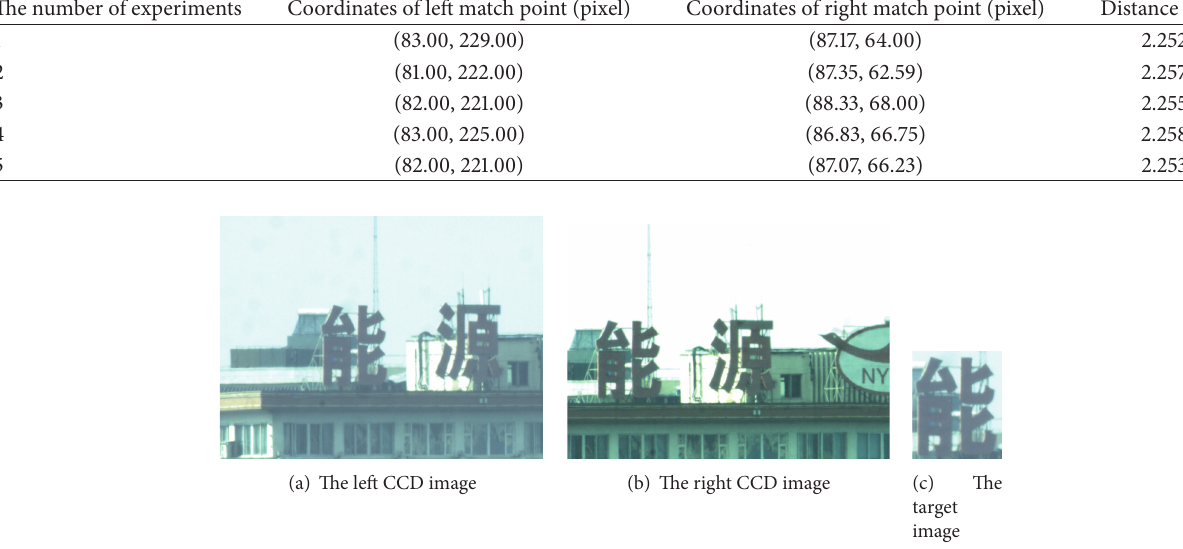
Figure 6: Ranging image groups for “Energy Bureau of Jilin Province.”